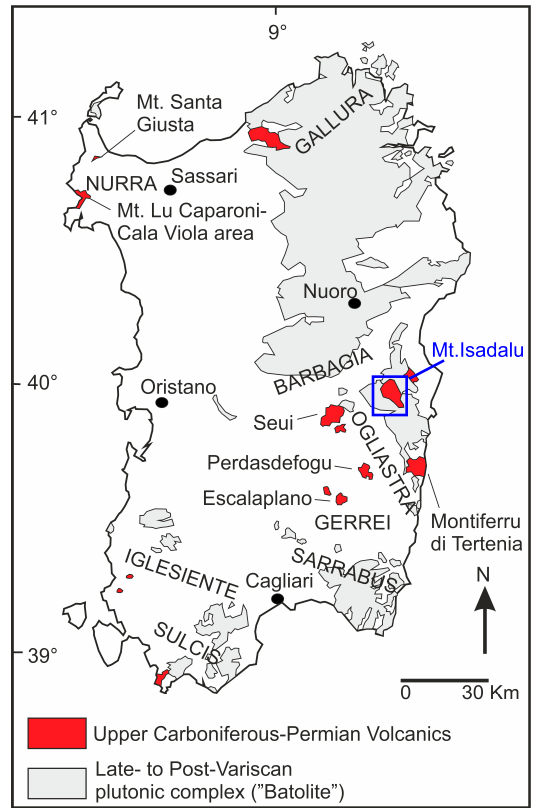
Figure 3. Simplified geological map of Sardinia showing the location of upper Paleozoic magmatic rocks of “Sardinia Batholith” and “Permian volcanic cycle” (modified after [38]). The blue rectangle indicates the Isadalu magmatic complex.